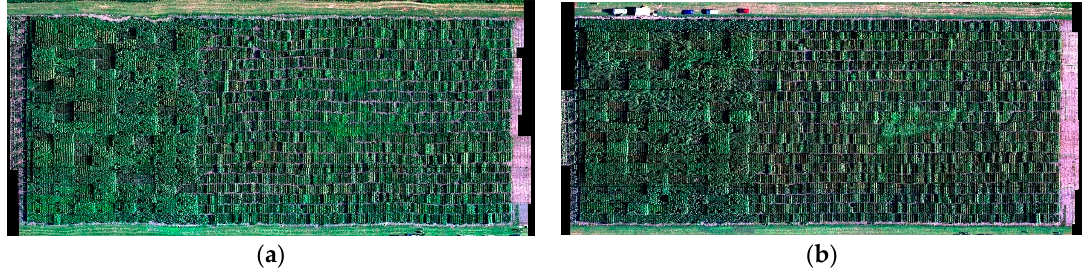
Figure 12. Mosaicked refined hyperspectral orthophoto through the proposed approach: ( a ) acquired data on 4 August 2015 and ( b ) acquired data on 21 August 2015.